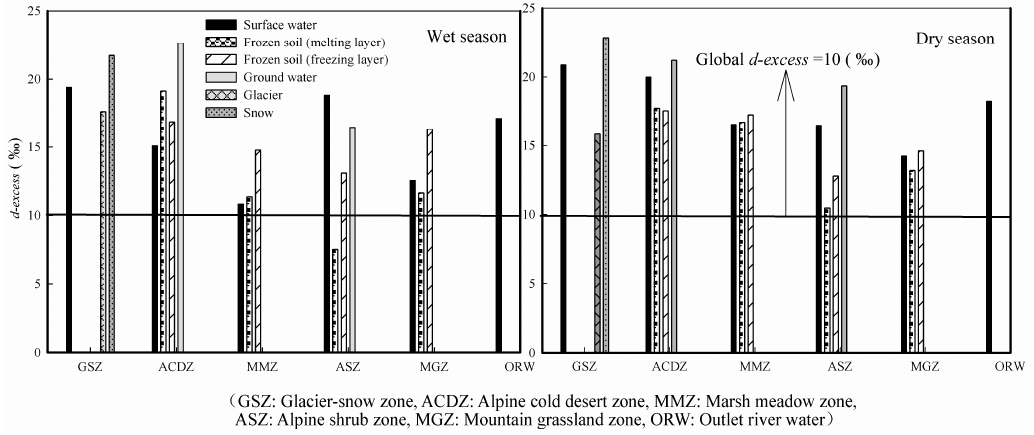
Figure 4. Spatial variation in d -excess (deuterium excess) of various samples in the different landscape zones.